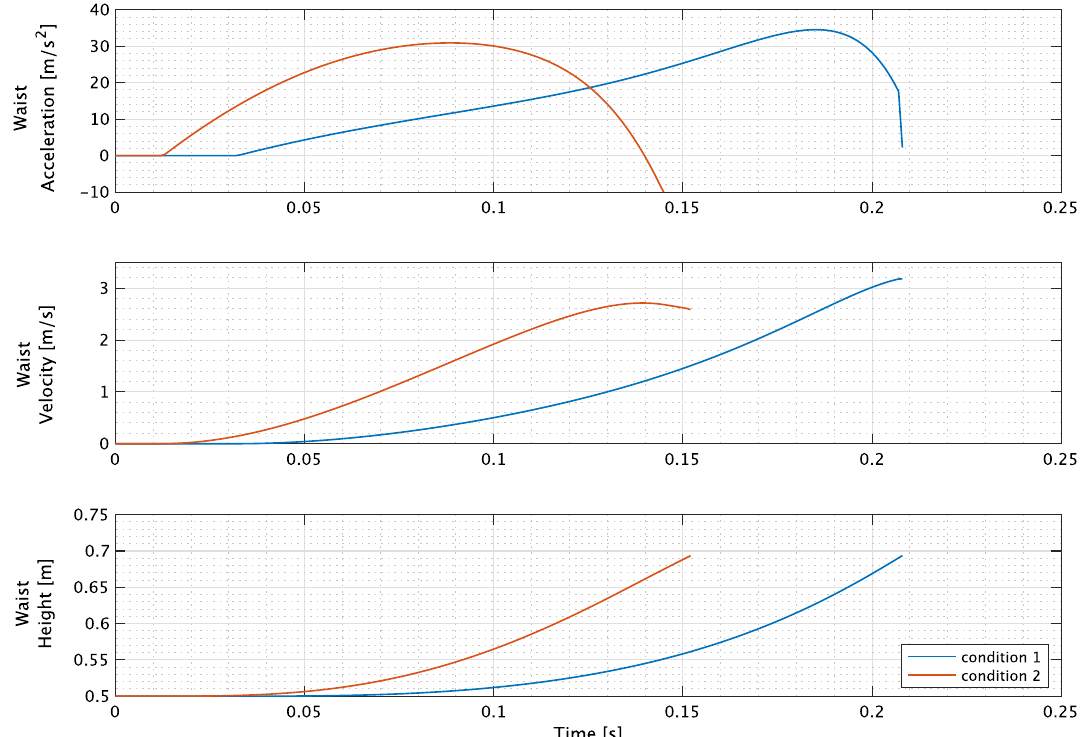
Fig. 6 Time variation in velocity and height with respect to time variation in acceleration under two waist conditions. Velocity at takeoff ( h = 0.7 m) is greater in Condition 1 than in Condition 2. Condition 1(Blue line): ¨ y w ( t ) is large at large t Condition 2(Red line): ¨ y w ( t ) is large at small t